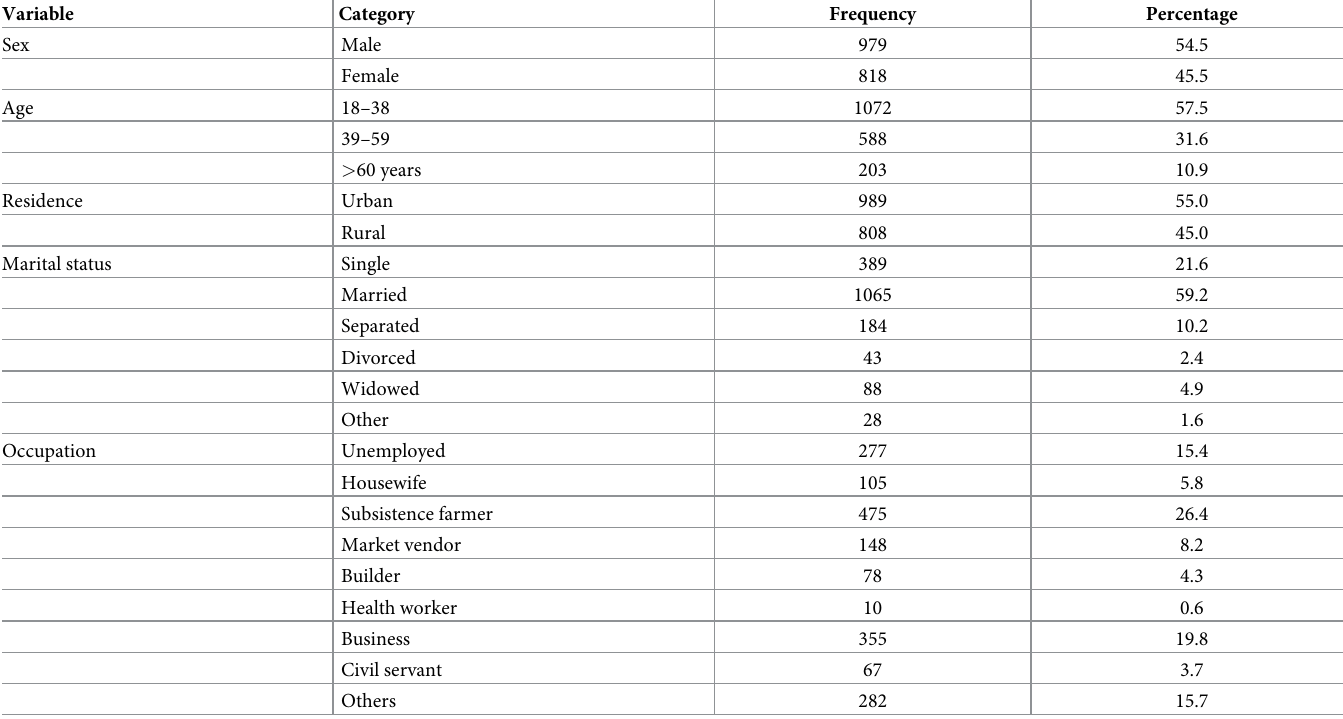
Table 1. Socio-demographic characteristics of adults enrolled in health care services with respiratory symptoms (n = 1797).